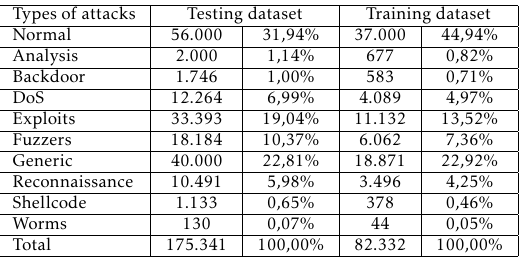
Table 1. Information about UNSW-NB15 dataset